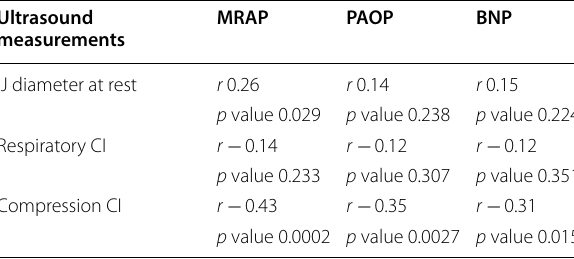
Table 4 Spearman correlation coefficients between ultrasound measurements and markers of volume